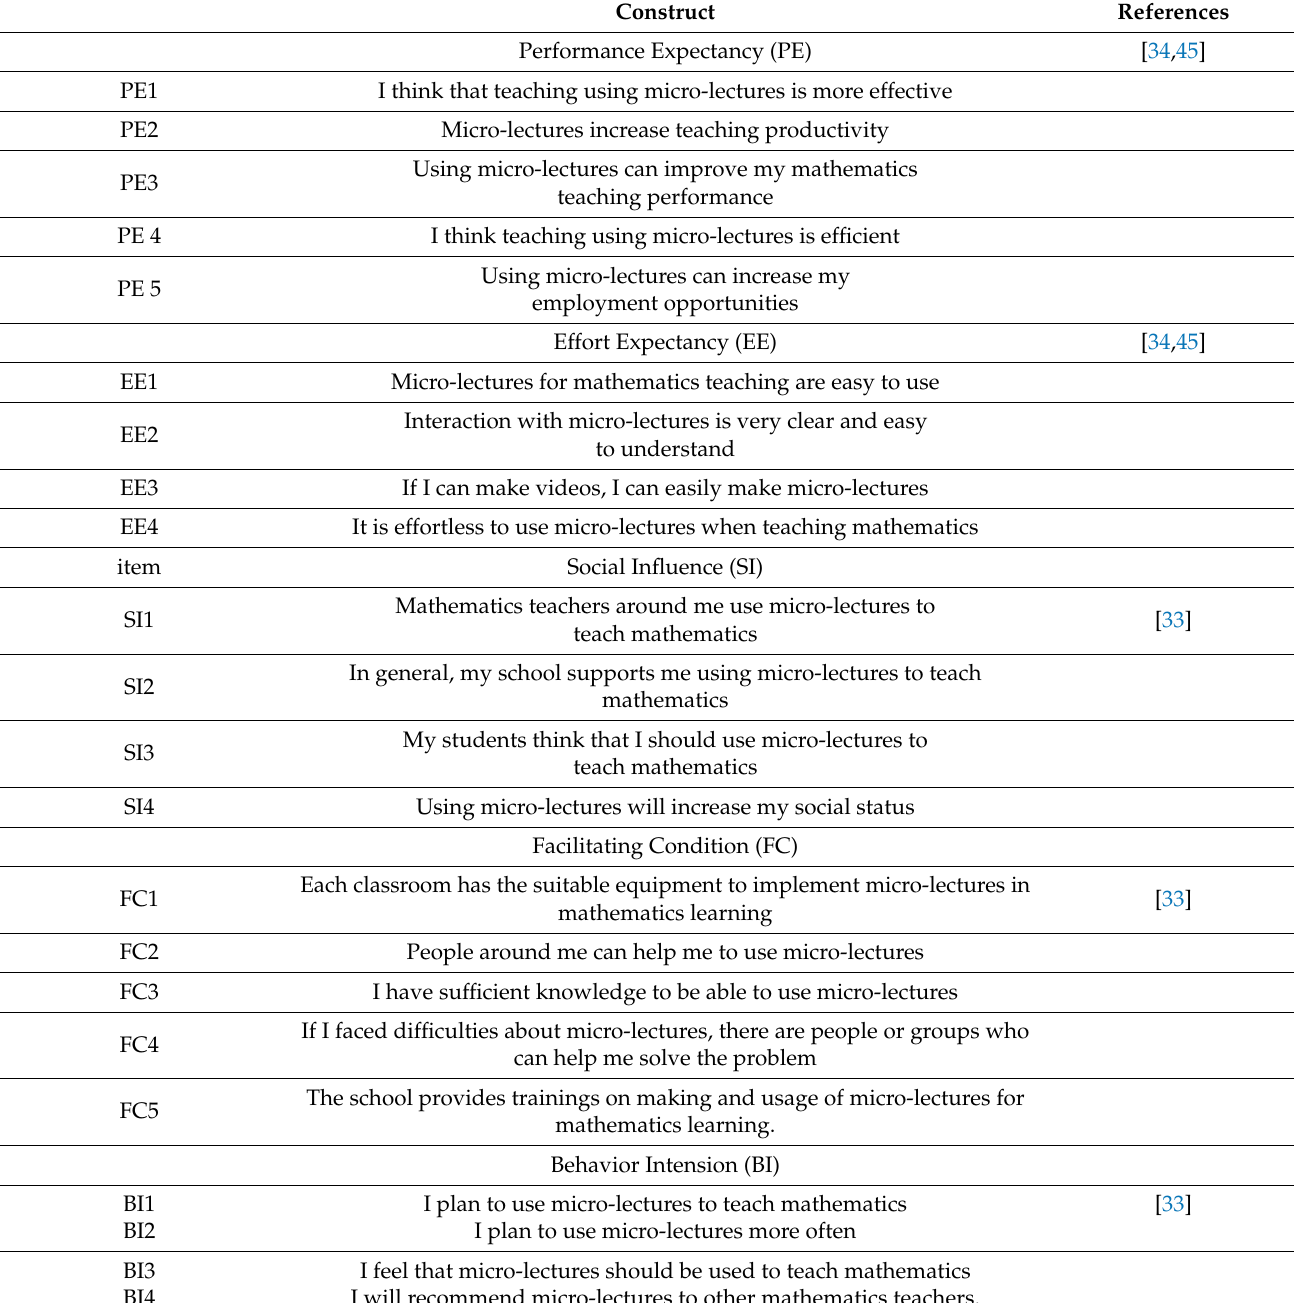
Table 1. Questionnaire items to analyze the intentions and actual use of junior high school teachers using